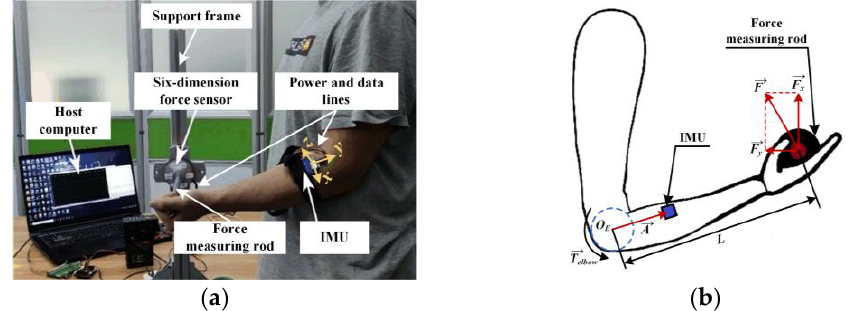
Figure 1. Information collection process during elbow static flexion/extension: ( a ) measurement platform; ( b ) joint torque calculation model for